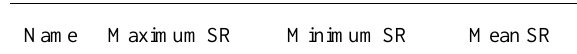
Table 2 Maximum, minimum and mean SRs (mm/yr) at P 1 , P 2 ,